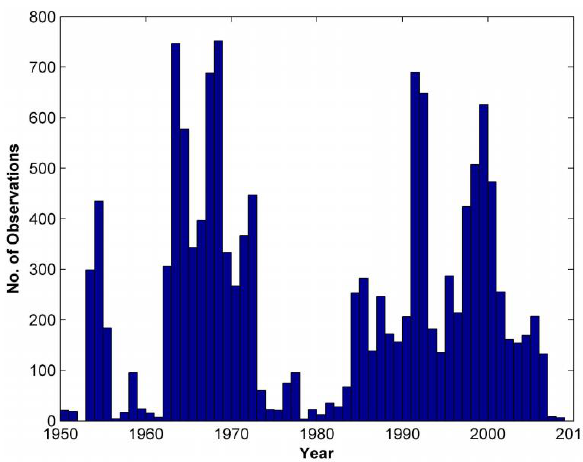
Figure 6. Number of observations per year, for the years 1950– Figure 6: Number of observations per year, for the years 1950-2010.993 2010.